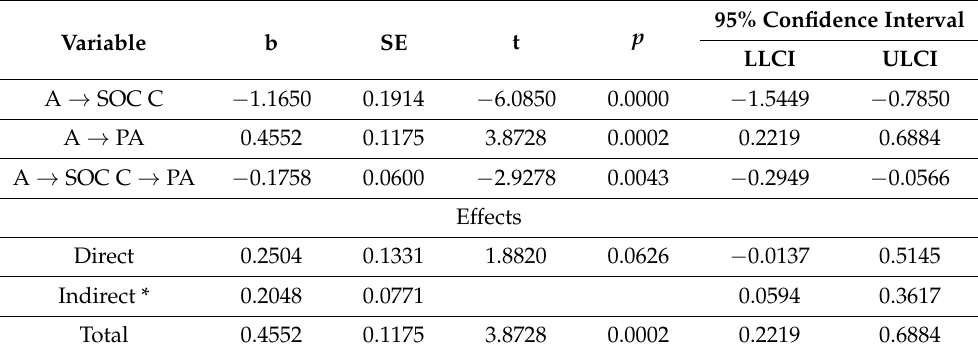
Table 9. Mediation analysis of manageability (SOC C) on anger (A)–physical aggression (PA) relationship.